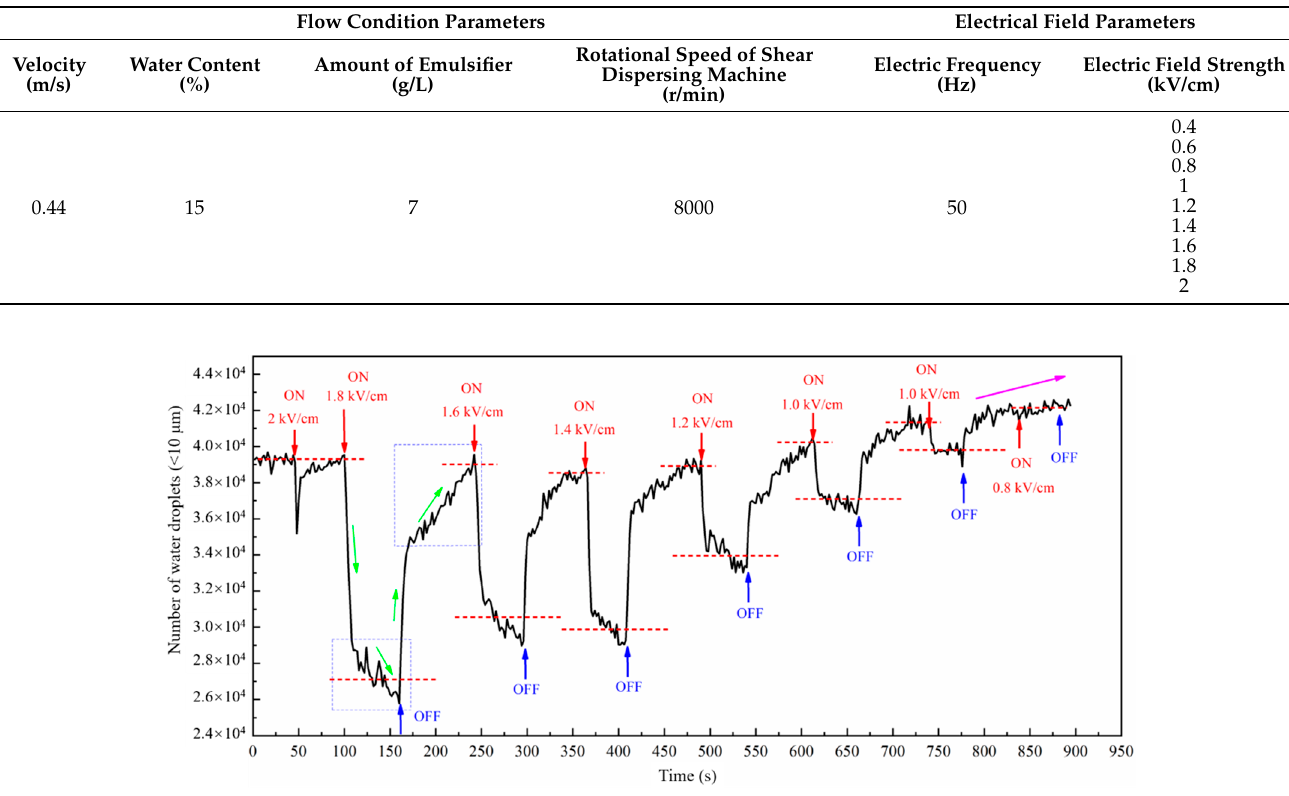
Figure 7. Variations of water droplet number within 10 µ m.